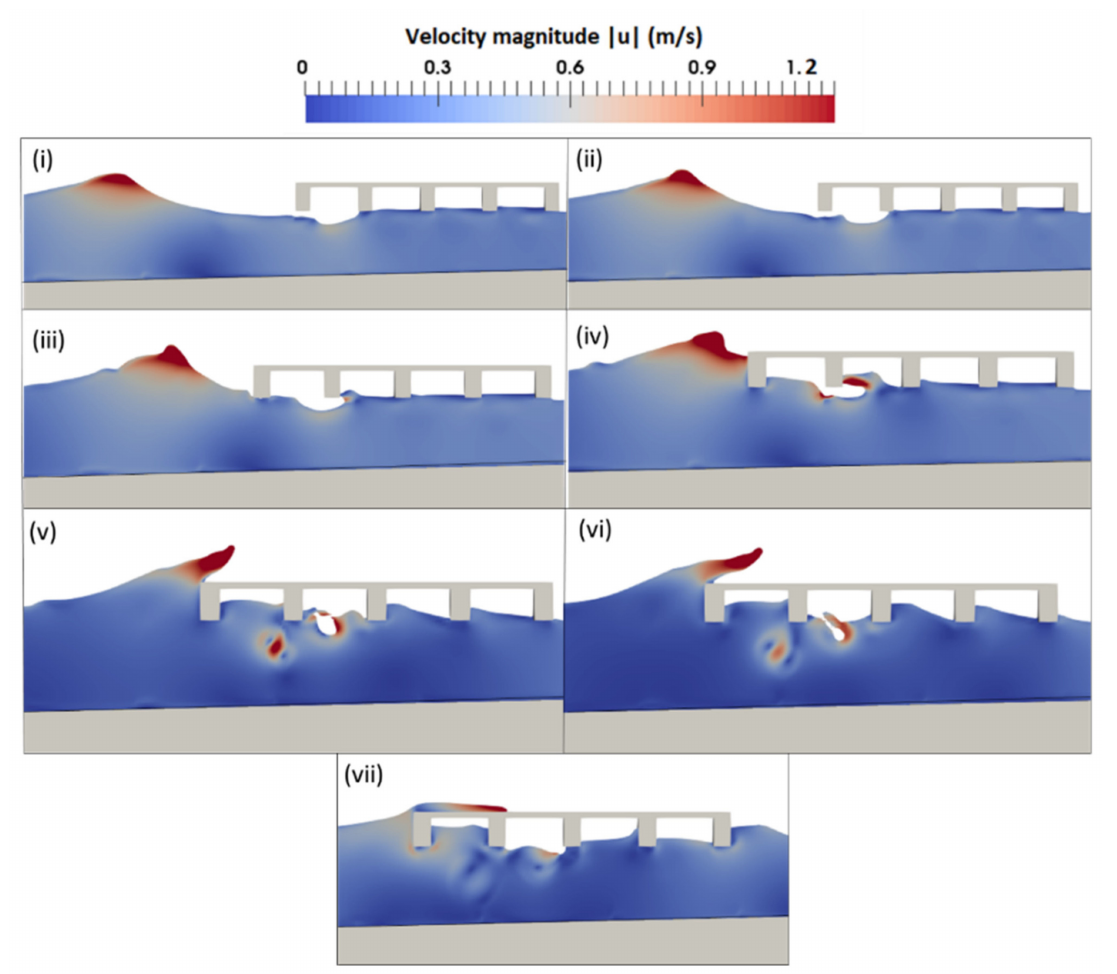
Figure 11. Velocity variation during breaking wave impact scenario WI-1 with the coastal deck struc- ture at normalized airgap ( S/d = 0.18) at different time steps ( i ) t = 15.7 s ( ii ) t = 15.8 s ( iii ) t = 15.95 s ( iv ) t = 16.05 s ( v ) t = 16.15 s ( vi ) t = 16.25 s and ( vii ) t = 16.4 s. The impact forces on the coastal deck structure varies with respect to the increasing airgap from the still water level. The horizontal velocity ( u ), vertical velocity ( w ) and pressure ( P ) variation along the vertical z -direction of the leading edge of the model (first girder) is plotted. The contribution of three wave impact events to the horizontal force from all the vertical girder surfaces are considered. The maximum values are determined by scanning the distributions over all the vertical surfaces of the structure, which shows that the peak values are at the leading edges of the model. Figure 14 shows the peak variations of velocities and pressure in the vertical z -direction for the first wave impact scenario (WI-1). The velocities are normalised with the corresponding celerity values, whereas the pressure is normalised by the stagnation pressure ( ρ C 2 ). The vertical axis represents the distance ‘ z (cid:48) measured from the SWL, which is normalised with the breaking wave amplitude ( η b ). Thus, the plots (Figure 14) show the peak values of velocity and pressure above the SWL with respect to the breaking wave amplitude. The normalised peak horizontal and vertical velocity increase with the increase in airgap ( S/d = 0.18 and 0.2). The peak values of the velocities are maximum above the SWL, when the z/ η b ratio is nearer to 1. This means the velocities are maximum at the tip of the crest, as is evident from Figure 6. The peak pressure values at the SWL are higher when the structure is placed at higher airgaps ( S/d = 0.18 and 0.2, Figure